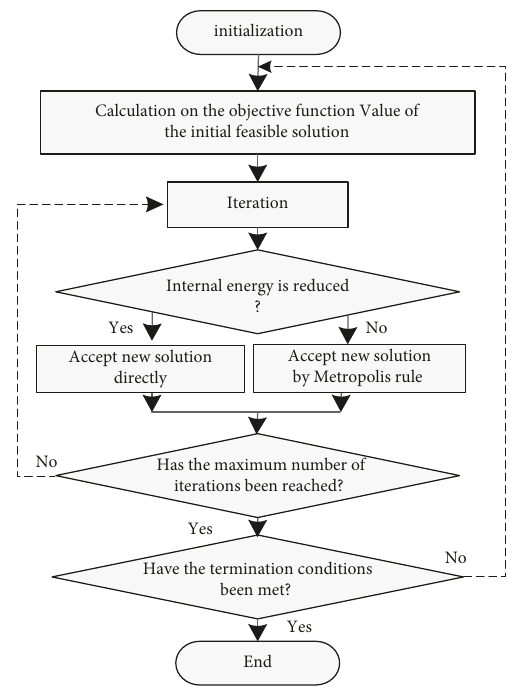
Figure 1: Technical roadmap of